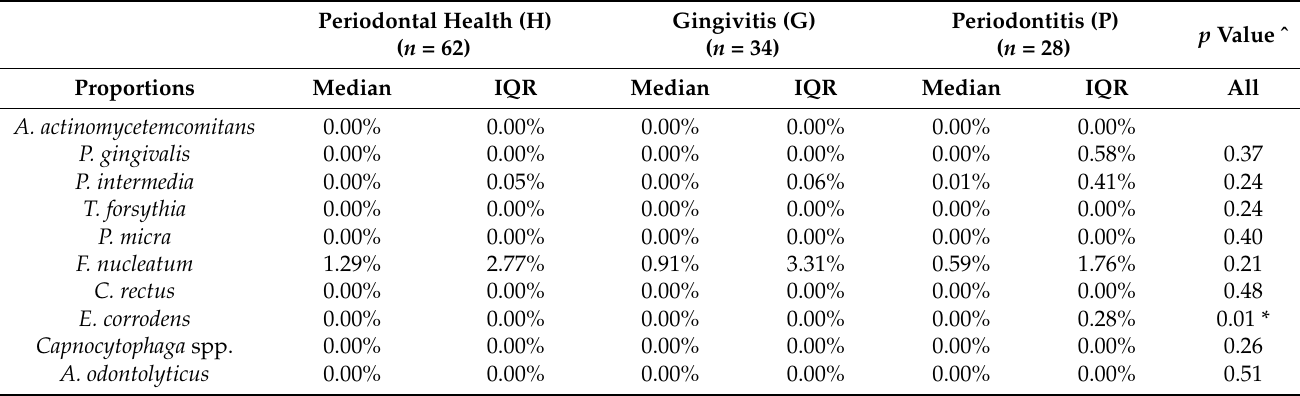
Table 5. Microbiological findings (culture), with proportions of total anaerobic microbiota in percentage, expressed as medians and interquartile ranks (IQR), for each study group, with the appropriate